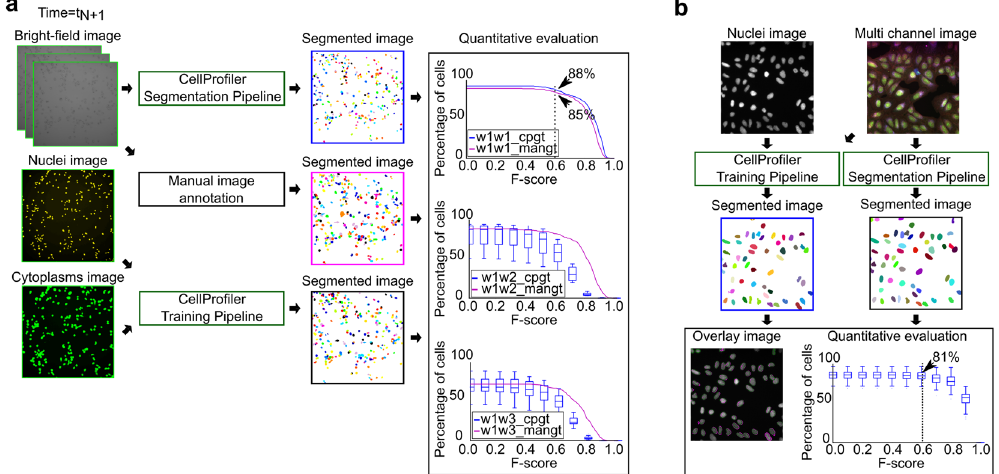
Figure 2. Segmentation evaluation pipelines. ( a ) In experiment 1, the previously un-seen bright-field channel of the test image was fed to the CellProfiler segmentation pipeline containing the trained DCNN. The same bright-field channel was manually annotated to create manual ground truth (‘mangt’) for comparison. The parallel fluorescent channels corresponding to the bright-field channel was fed to the CellProfiler training pipeline to create automatic ground truths for evaluation (‘cpgt’). Note that the ground truth generated for evaluation was not used for training. The three plots show the percentage of cells segmented with an F-score greater than or equal to the F-score value shown in the horizontal axis. ‘w1w1_cpgt’ corresponds to the result obtained when the DCNN was trained on eight sites of well 1 and tested on the ninth site of well 1 with CellProfiler created ground truth (blue line plot), while ‘w1w1_mangt’ corresponds to a comparison with with manual ground truth (magenta line plot). The plot shows that 88% of the cells were segmented with an F-score ≥ 0.6 when compared with automatic ground truth while 85% of the cells were segmented with an F-score ≥ 0.6 when compared with manual ground truth. The second plot shows the result when the DCNN was trained on well 1 and tested on well 2. The magenta plot shows the comparison done on the single manually annotated image site while the blue box plot shows the result when compared with all the nine image sites in well 2. Similarly, the third plot corresponds to the result when the DCNN was trained on well 1 and tested on well 3. ( b ) In experiment 2, a four-channel input image and the nuclei channel were used to create the ground truth for training the DCNN. The trained DCNN was used to segment the four-channel test image. The result of the segmentation from the CellProfiler pipelines for creating ground truth and the segmentation pipeline using DCNN is overlaid on the nuclei image. The quantitative evaluation shows the percentage of cells greater than or equal to a particular threshold v/s the corresponding F-score values. The box plot shows when the comparison was done for 58 images. The median value shows that around 81% of cells were segmented with F-score ≥